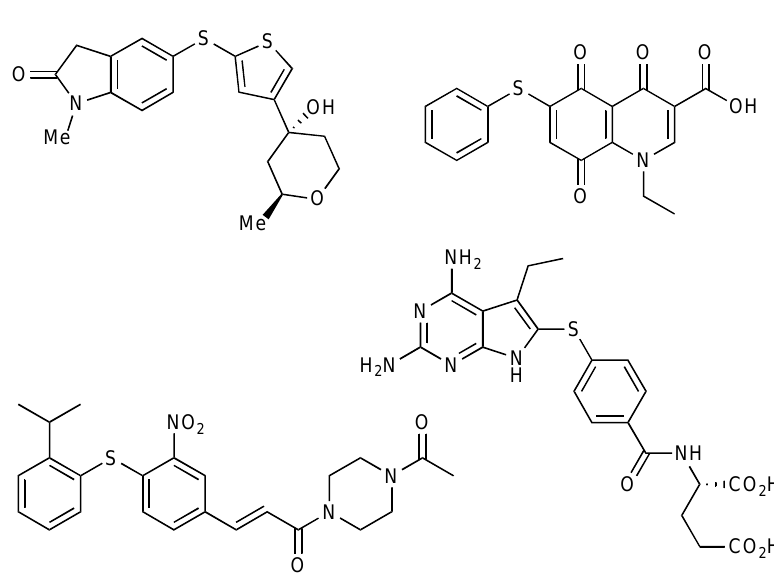
Figure 1. Aryl sulfide-containing